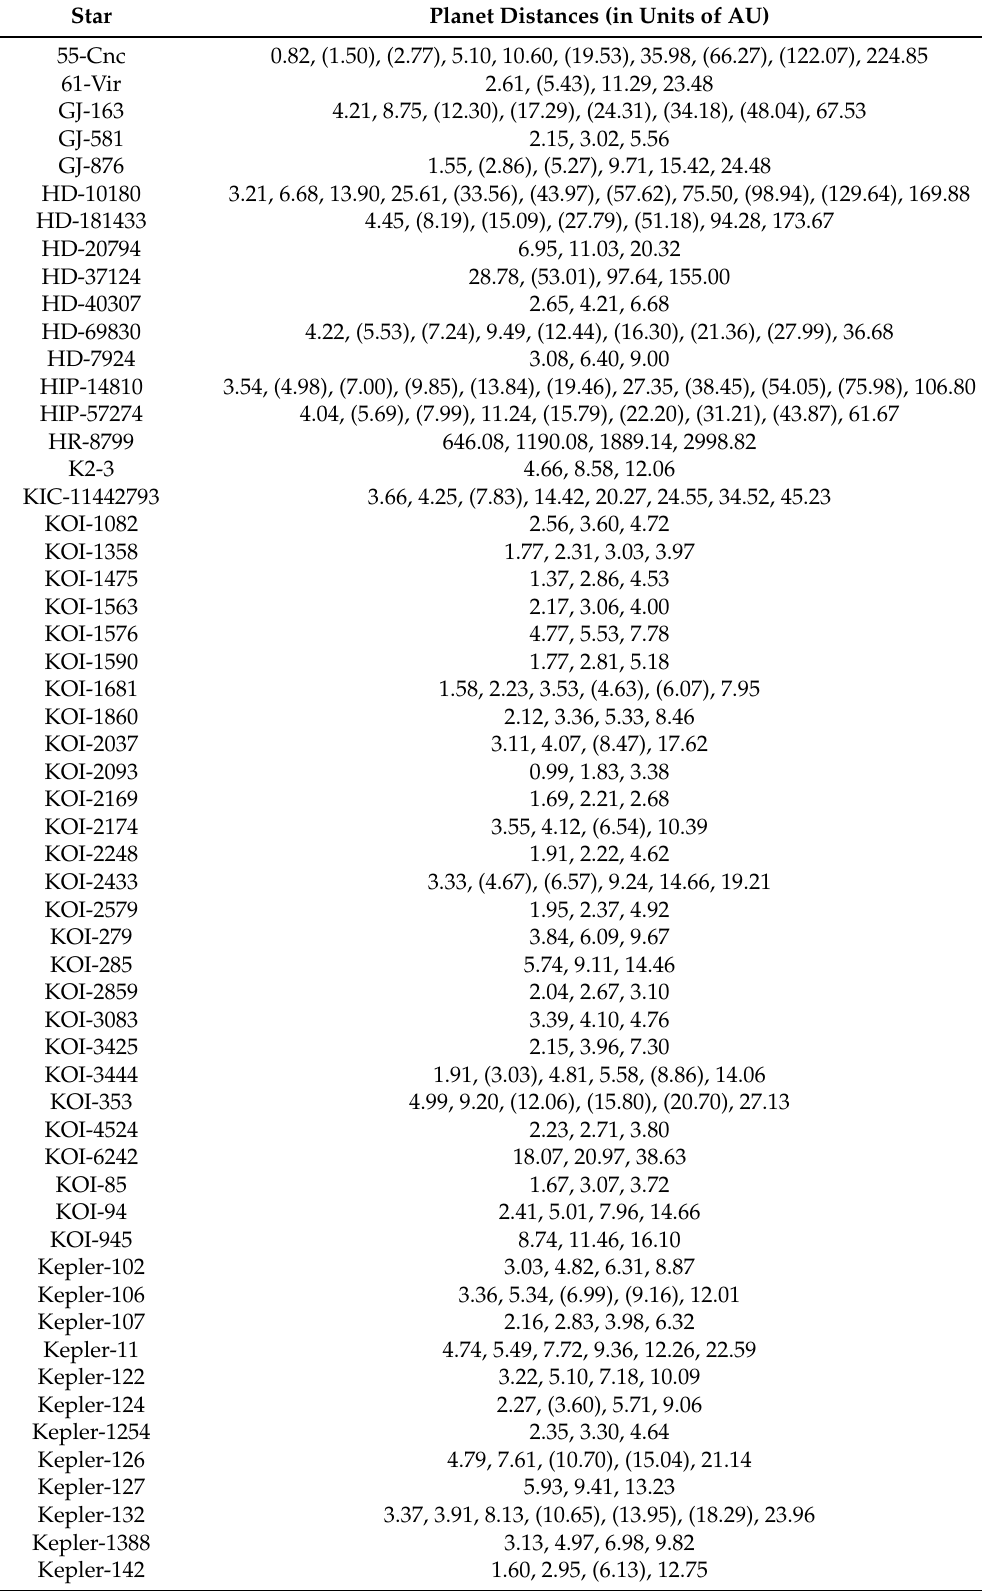
Table 2. Observed and predicted (in parentheses) distances of exoplanets. Planet Distances (in Units of